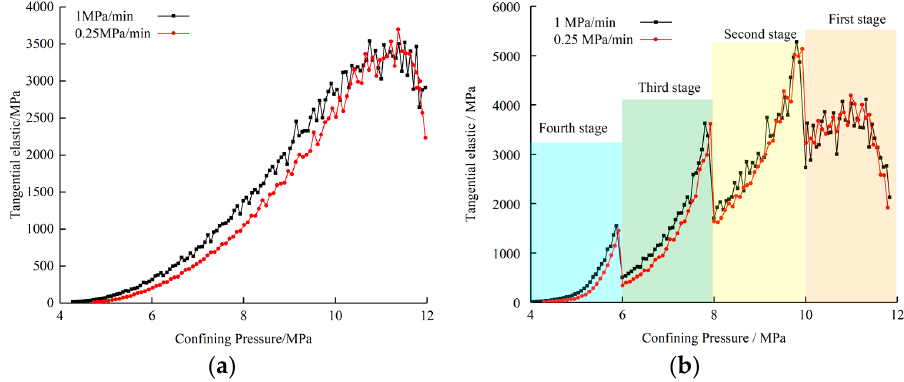
Figure 9. Tangential modulus of tectonic coal: ( a ) Continuous unloading path; ( b ) Cyclic unloading path (First cycle of each unloading levels).